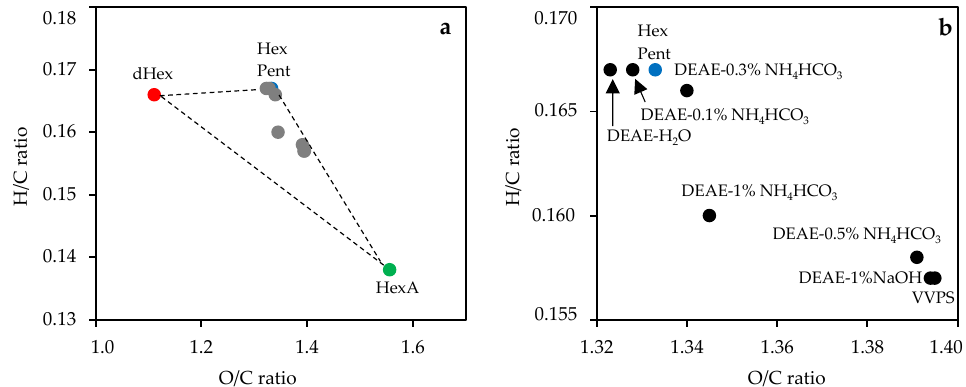
Figure 2. Van Krevelen diagram (correlation between O/C ratio and H/C ratio) for VVPS, DEAE– cellulose fractions (labeled as eluent type), hexose (Hex), pentose (Pent), desoxyhexose (dHex), and hexuronic acid (HexA) ( a ) and its enlarged fragment ( b ). Abbreviation used: VVPS, V. vitis-idaea total polysaccharide fraction; DEAE, diethylaminoethyl cellulose.